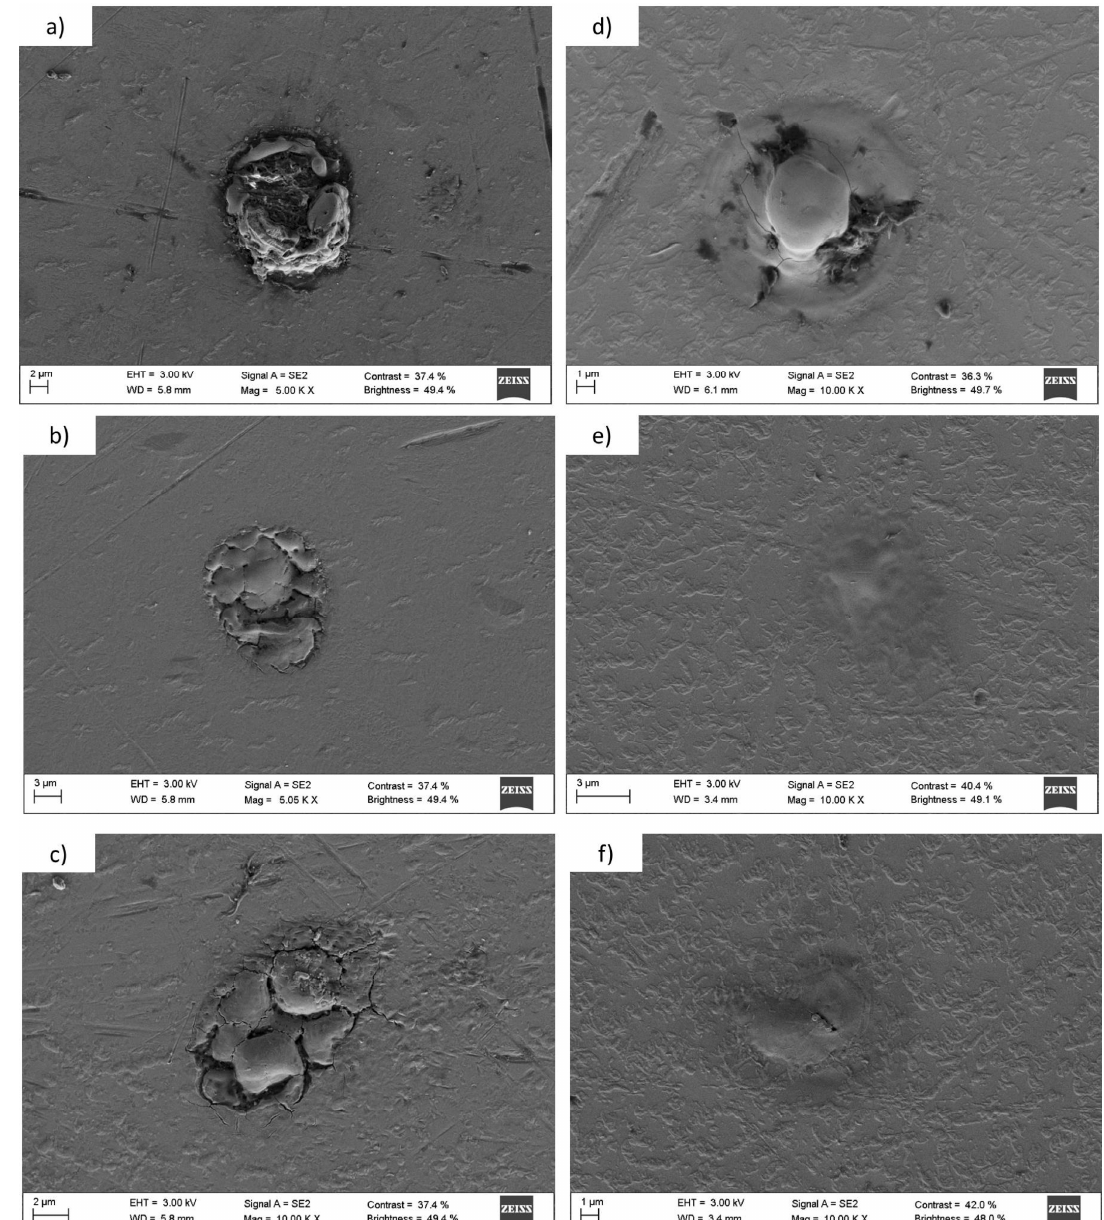
Figure 8. SEM images of the microholes fabricated with the microlenses and the Talbot